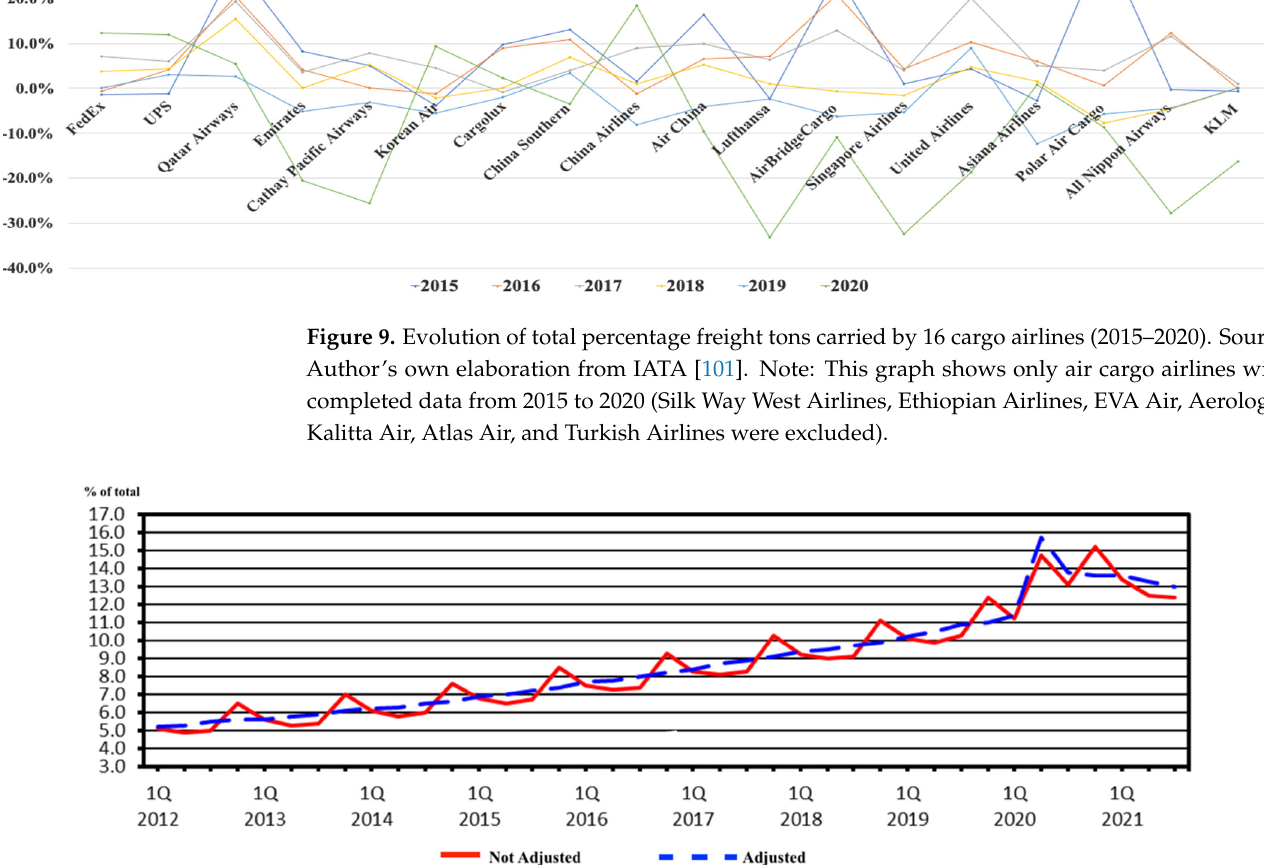
Figure 10. Quarterly retail e-commerce sales in US from 2012 to 3rd quarter 2021. Source: US Department of Commerce [129]. Note: Statement regarding COVID-19 impact: The Census Bureau continues to monitor response and data quality and has determined that estimates in this release meet publication standards.